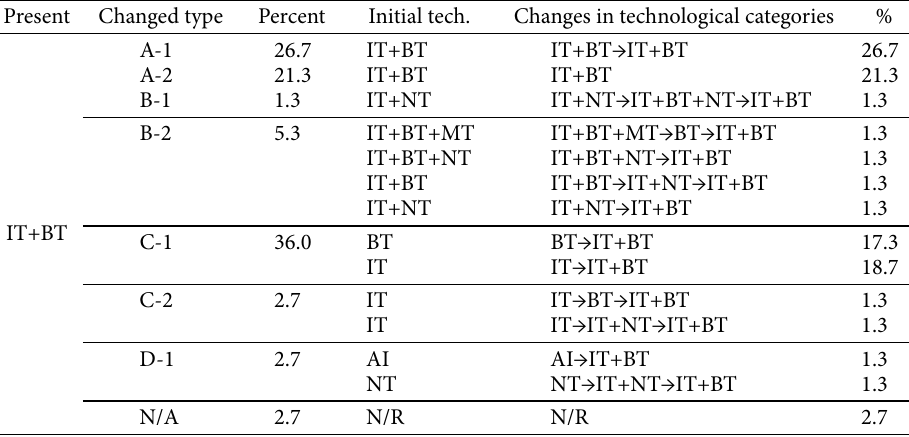
Table 1. Career movements in the IT+BT convergence technology Present Changed type Percent Initial tech. Changes in technological